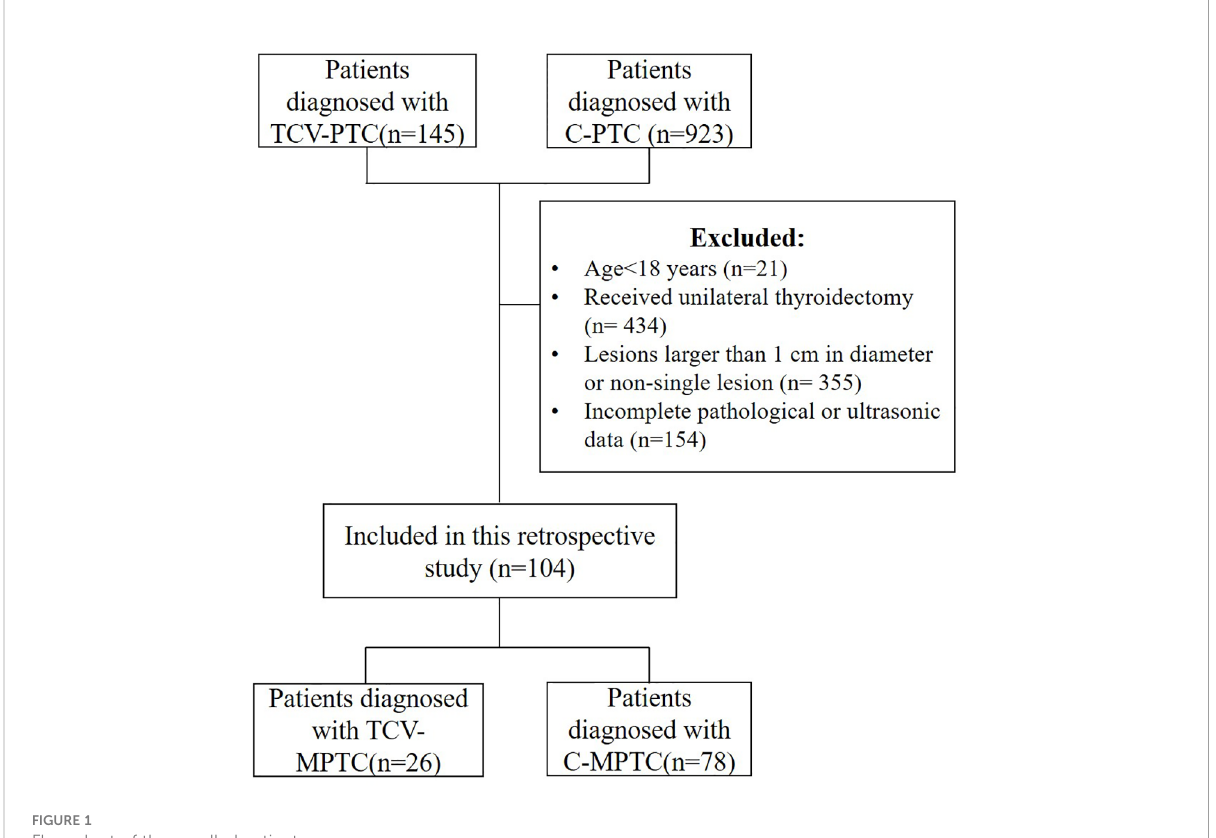
FIGURE 1 Flow chart of the enrolled